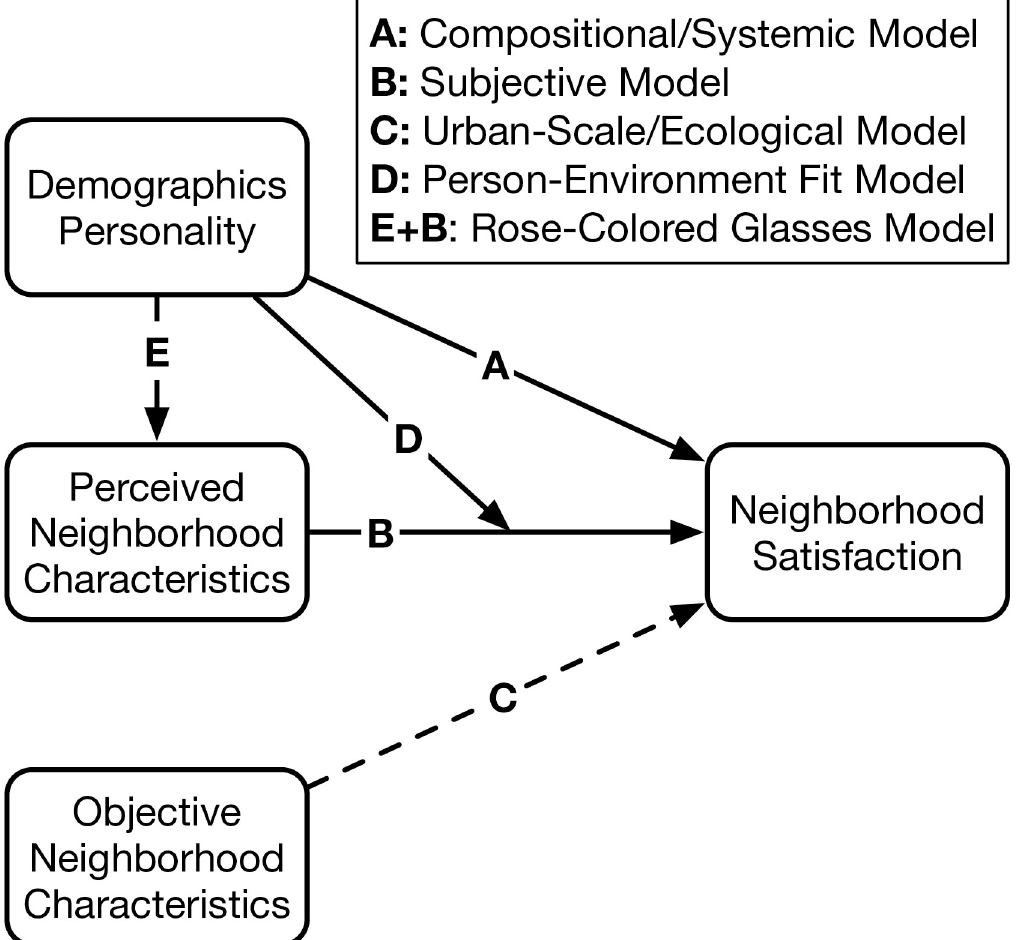
Fig 1. Pathways to neighborhood